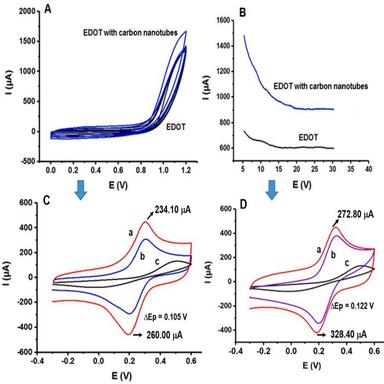
Comparison of the electropolymerization curves for EDOT with MWCNTs and EDOT onto PGE A) cyclic voltammetry results, B) constant potential electrolysis results, C) and D) electrochemical responses of the so-formed electrodes in redox probe containing 0.1 M KCl electrolyte.